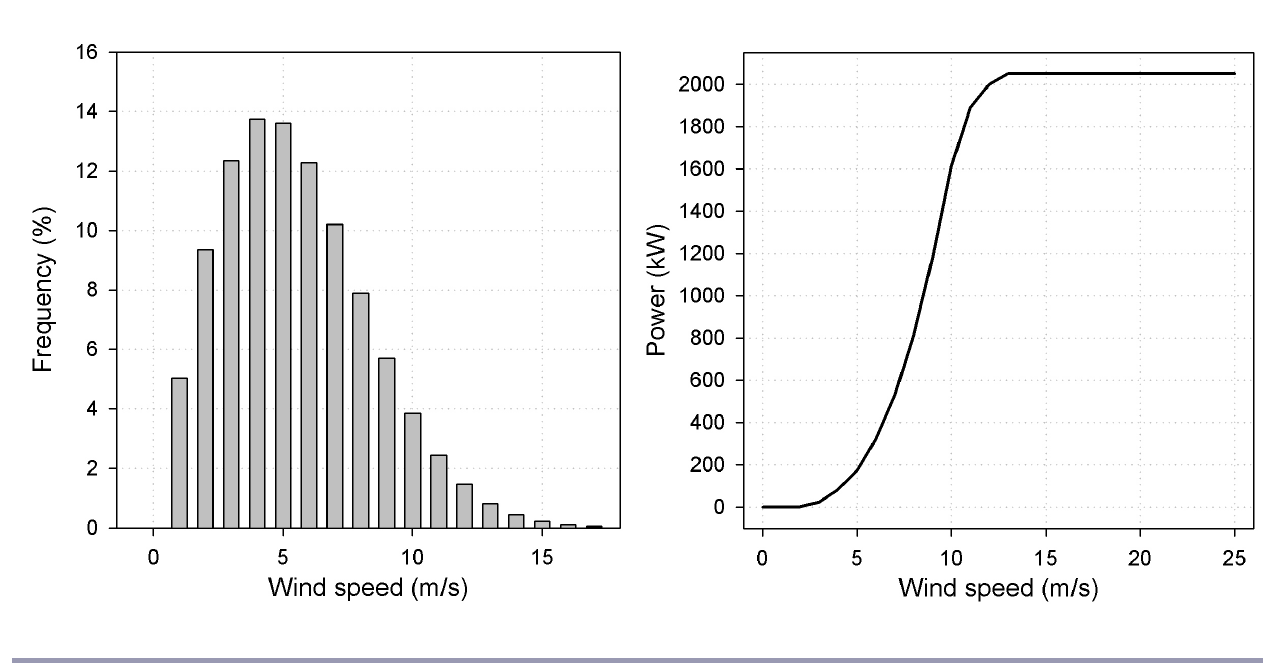
Fig. 2 . Calculation of the produced wind power for a particular site. Left panel: example of a wind speed frequency distribution; right panel: power curve for the selected technology option (ENERCON